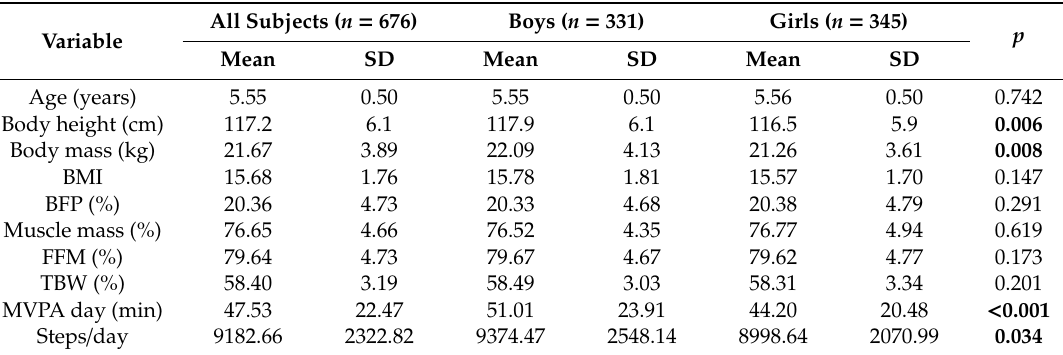
Table 1. Characteristics of the study